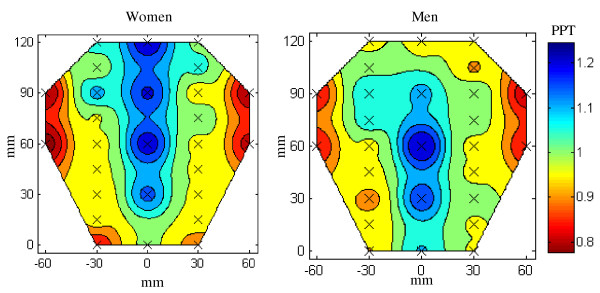
Normalized pressure pain threshold maps of the low back region for women (N = 11) and men (N = 11). Note the lowest sensitivity along the spine. Also note the symmetry along the spine in both genders.